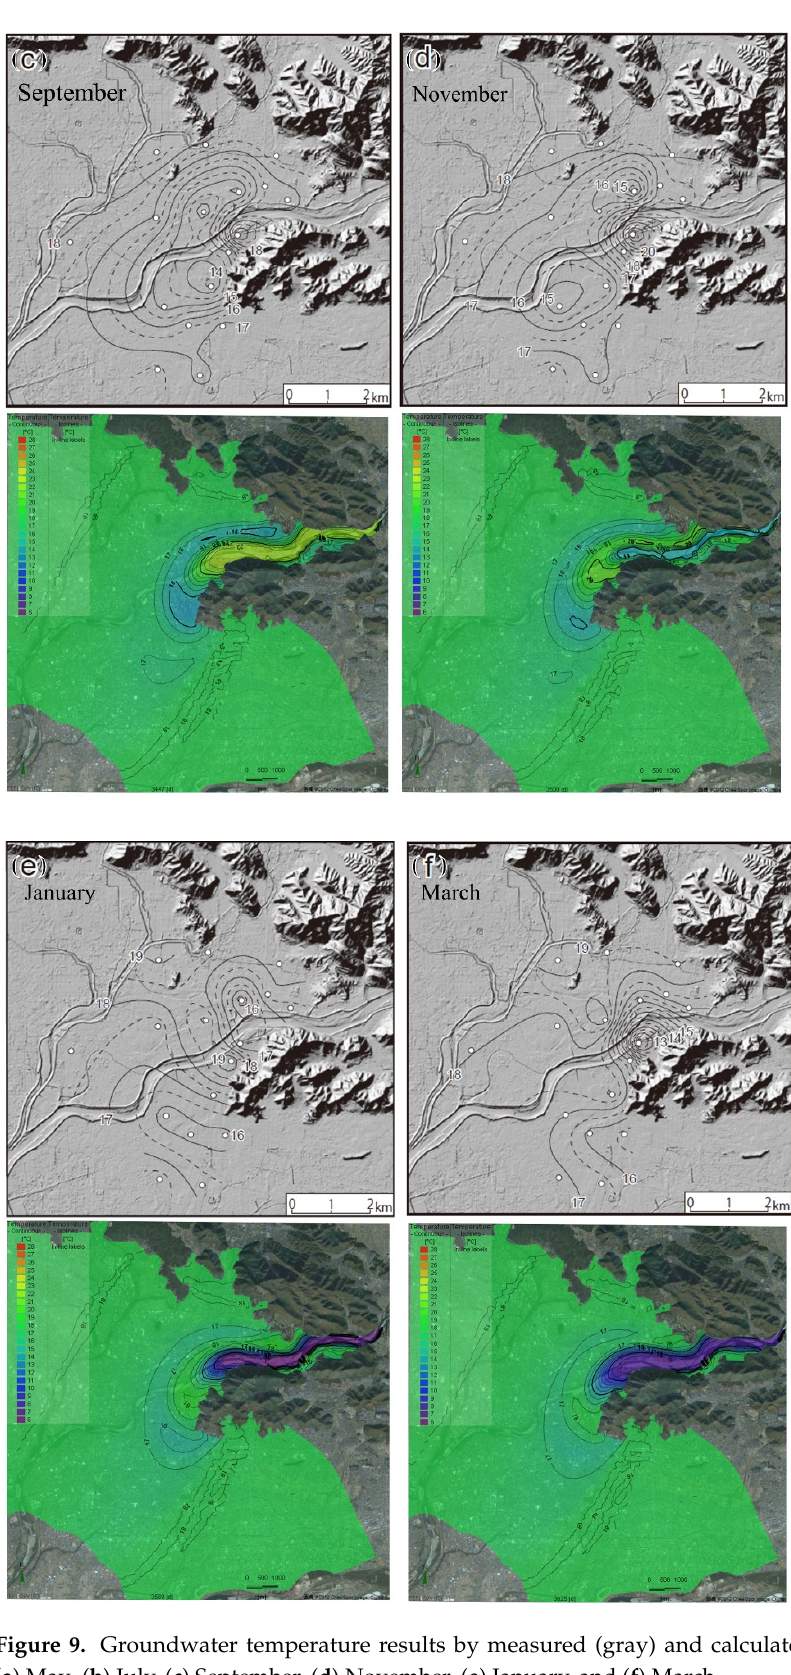
Figure 9. Groundwater temperature results by measured (gray) and calculated (color) data for ( a ) May, ( b ) July, ( c ) September, ( d ) November, ( e ) January, and ( f ) March.